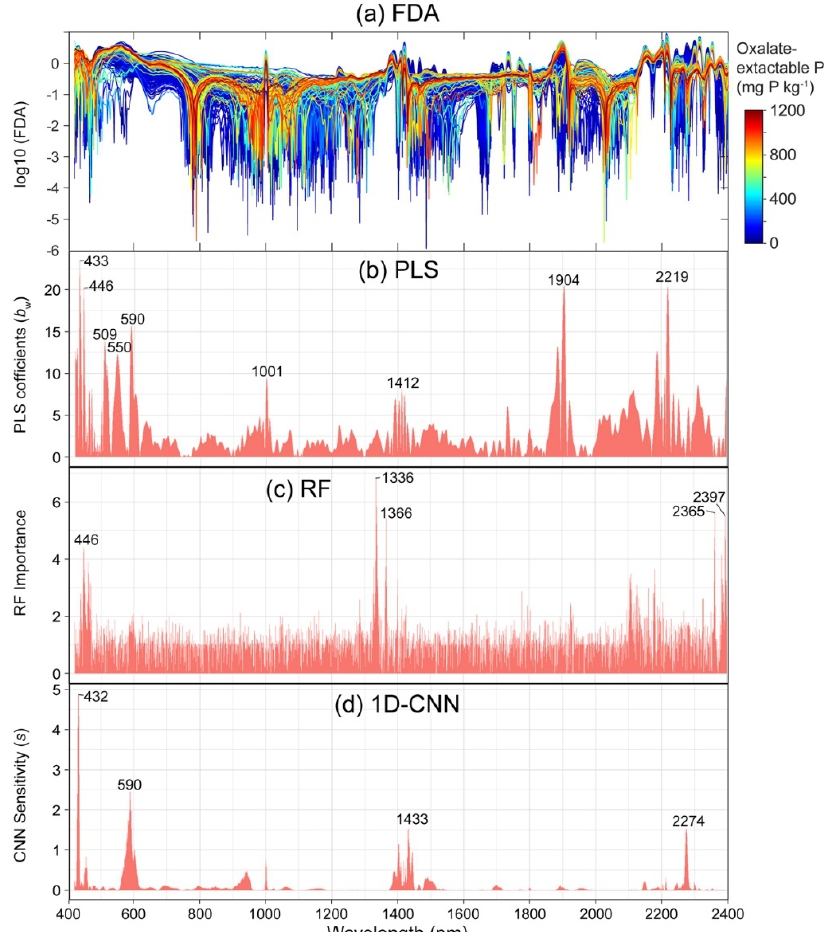
Figure 5. ( a ) First derivative absorbance (FDA) spectra on log10 scale of soil oxalate-extractable P (Pox) content and importance of wavelength to ( b ) partial least squares (PLS), ( c ) random forest (RF), and ( d ) one dimensional convolutional neural network (1D-CNN) models in soil Pox estima-